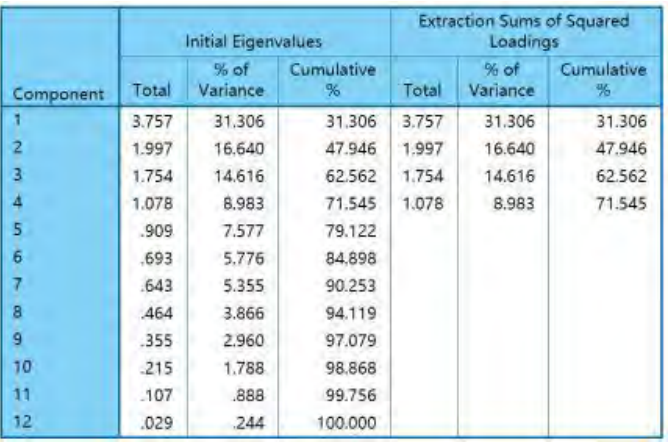
Table2. Total variance explained by orthogonal